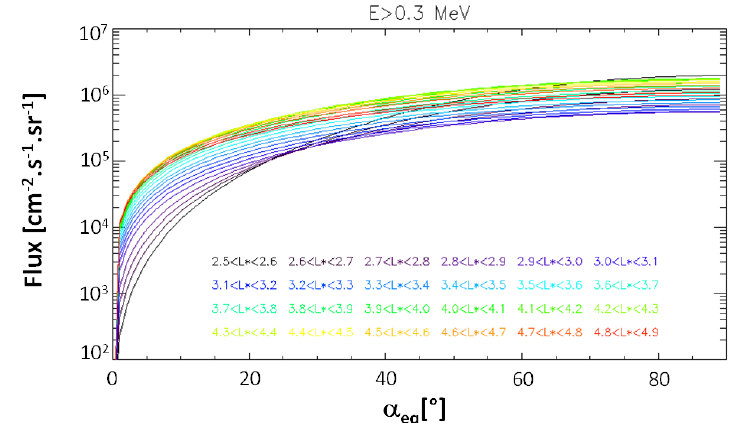
Figure 5. Electron fluxes along magnetic field lines (90 ◦ corresponds to the Equator) for energy >0.3MeV and for all L ∗ intervals of the SLOT model (in color).